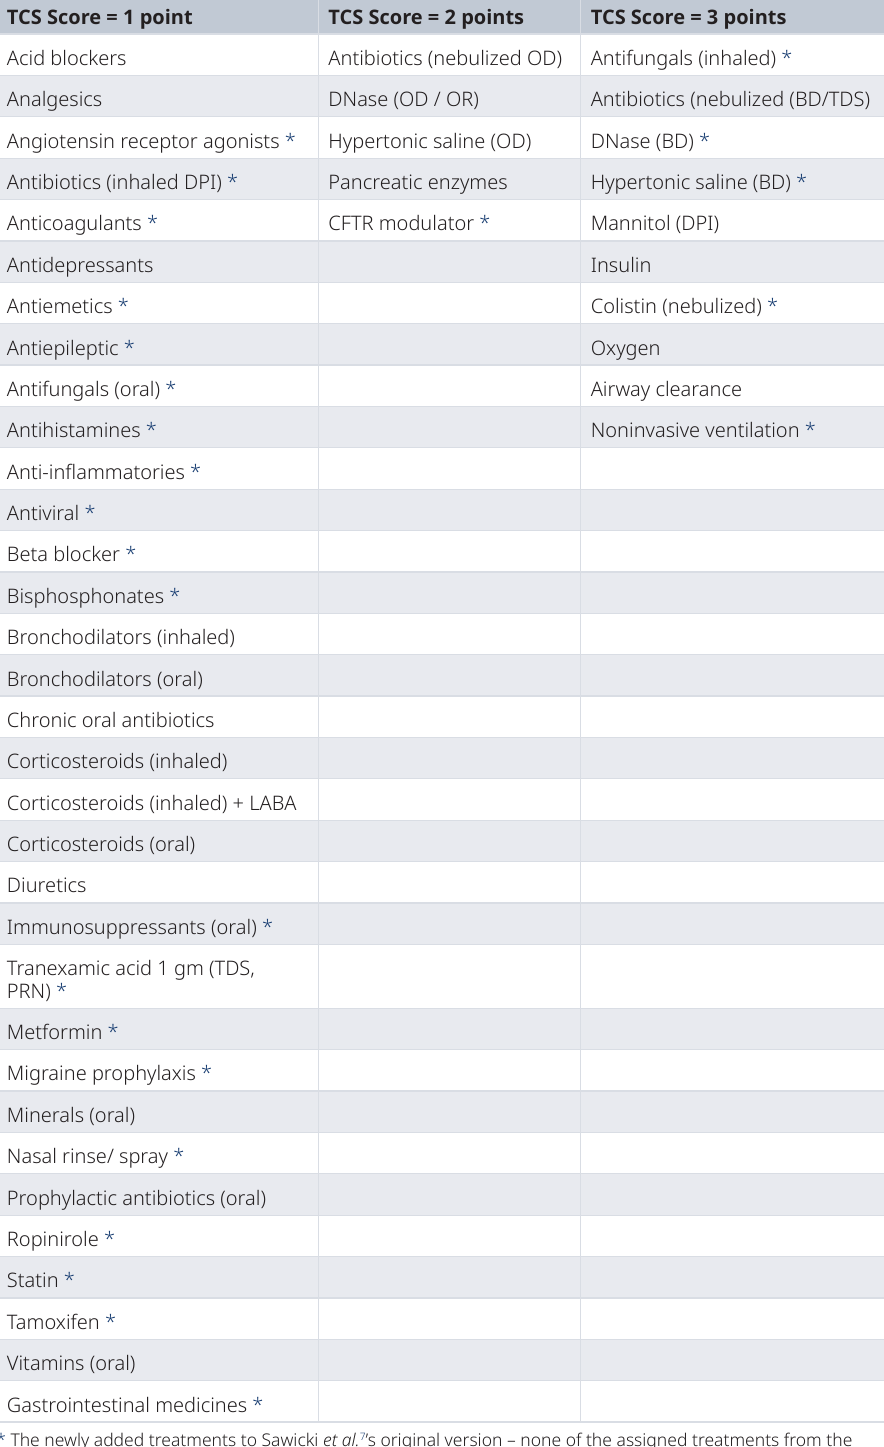
Table 1. The modified version of Sawicki et al. 7 ’s treatment complexity score